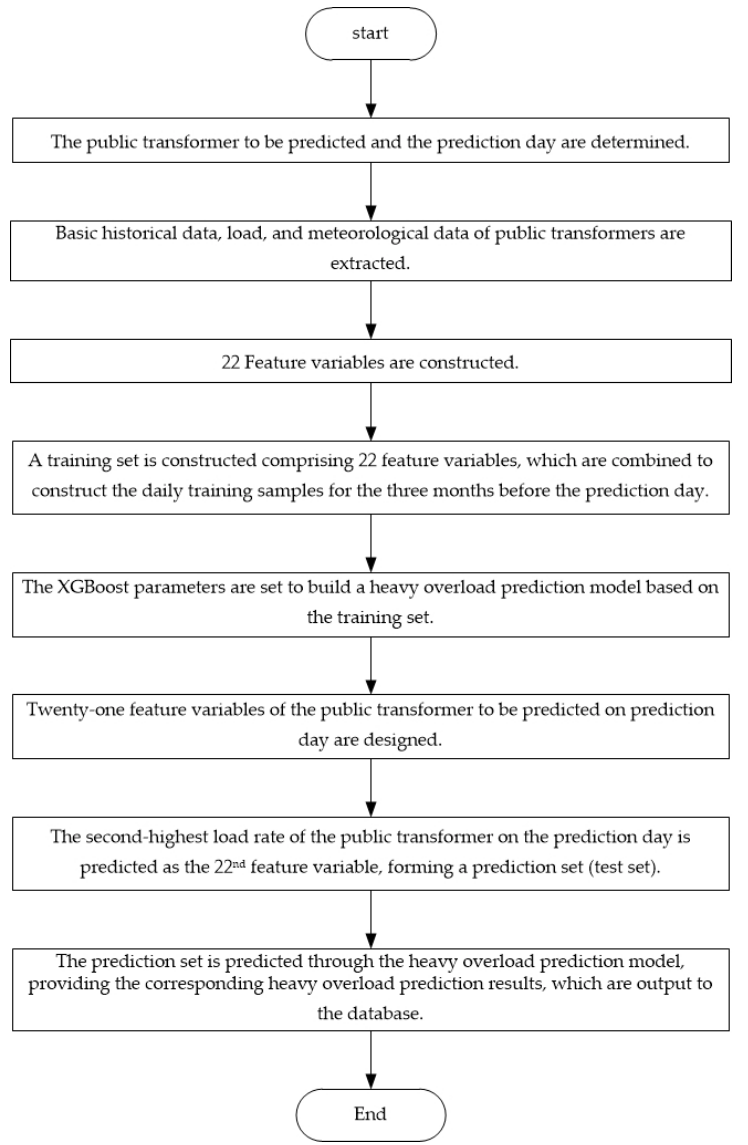
Figure 10. The flowchart of short-term heavy overload prediction of public transformers based on combined LSTM-XGBoost model.